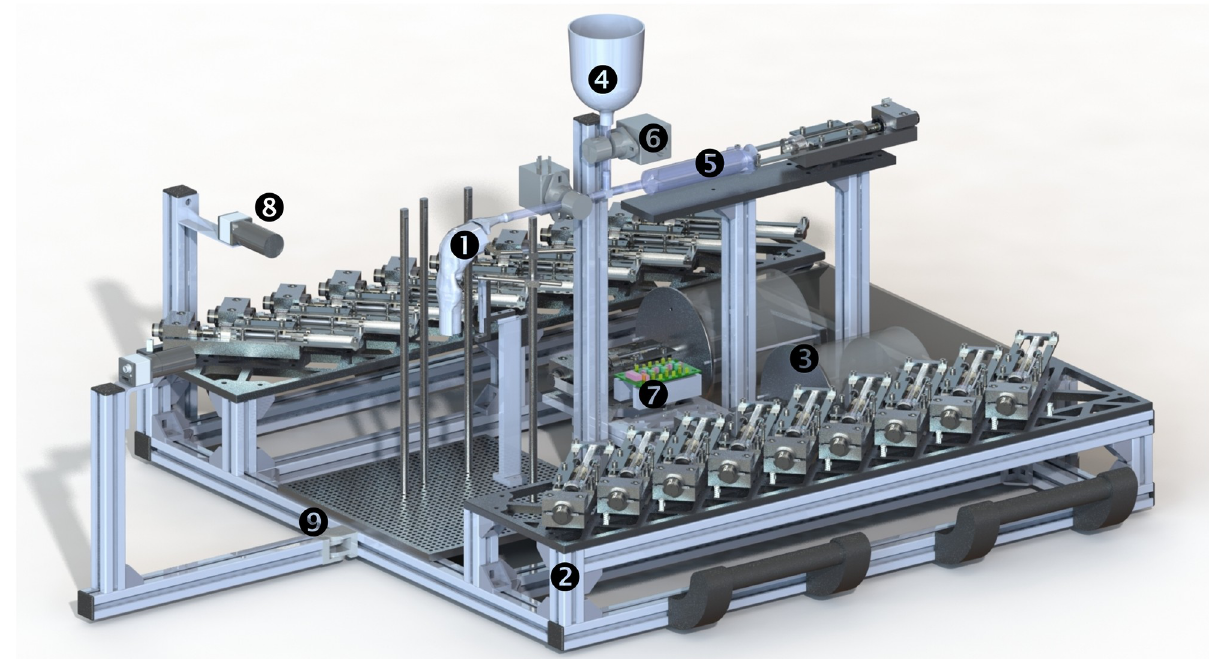
Fig 2. Overview of Swall-E swallowing robot —actuation wires, electrical cables and power supply non depicted: (1) synthetic anatomical conduit; (2) actuator; (3) pressure generator; (4) bolus storage tank; (5) motorized syringe; (6) solenoid valve; (7) electronic card board and microcontroller; (8) lateral high-speed camera; (9) aluminum